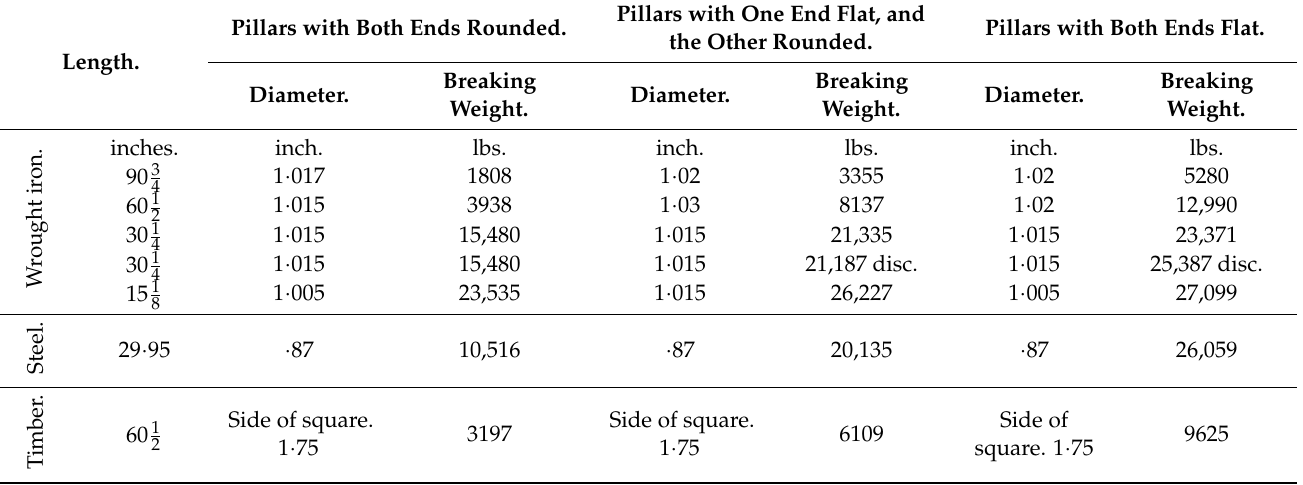
Table 1. Early 19th century data (quoted to an absurd level of precision) on the failure loads of wrought iron, steel and timber pillars of various lengths and diameters. From [48]. Pillars with One End Flat, and Pillars with Both Ends Rounded. Pillars with Both Ends Flat. the Other Rounded. Length. Breaking Breaking Breaking Diameter. Diameter. Diameter. Weight. Weight. Weight. lbs. inch. lbs. inch.